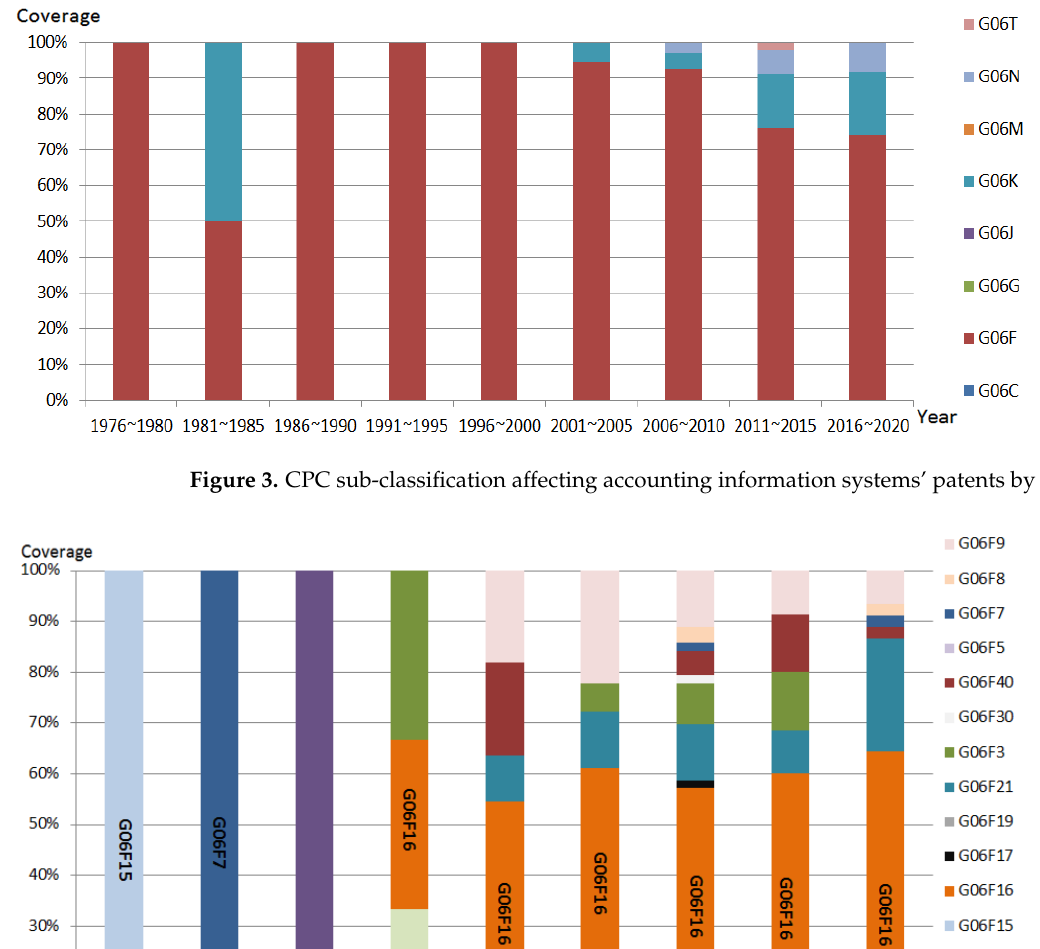
Figure 5. Sub-classification of G06F codes of software patents affecting patents on the main paths of accounting information systems by year. A common trend in Figures 4 and 5 is that before the 1990s, G06F7 and G06F15 mainly influenced accounting information systems ’ patents, and from the 1990s, G06F16 had a dominant influence on accounting information systems ’ patents. As mentioned earlier, the CPC codes of the software patents that affected accounting information sys- tems ’ patents from the 1970s to the 1990s are G06F7 and G06F15. G06F7 is to sort, select, merge, or compare data, or to perform functional evaluation by calculation. This soft-